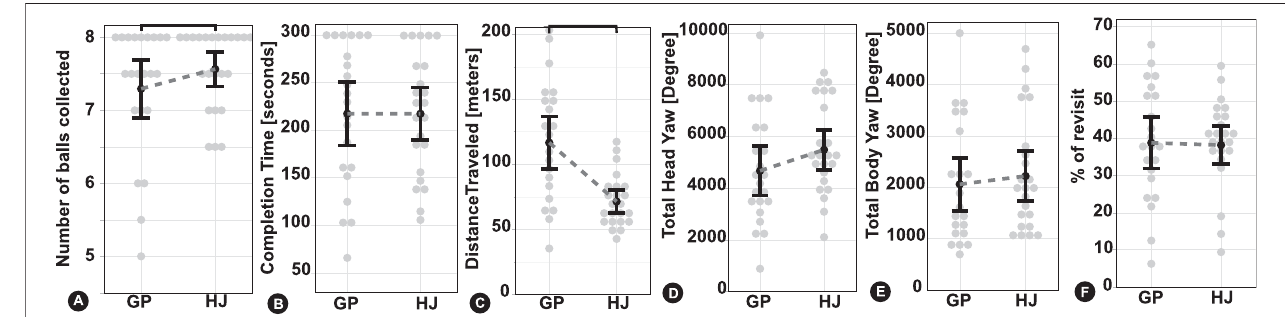
FIGURE 4 | Behavioral data plot for Gamepad (GP) and HeadJoystick (HJ) with an overall mean (black dots), individual participants ’ average (gray dots) and error bars at 95% Con fi dence Intervals (CI).